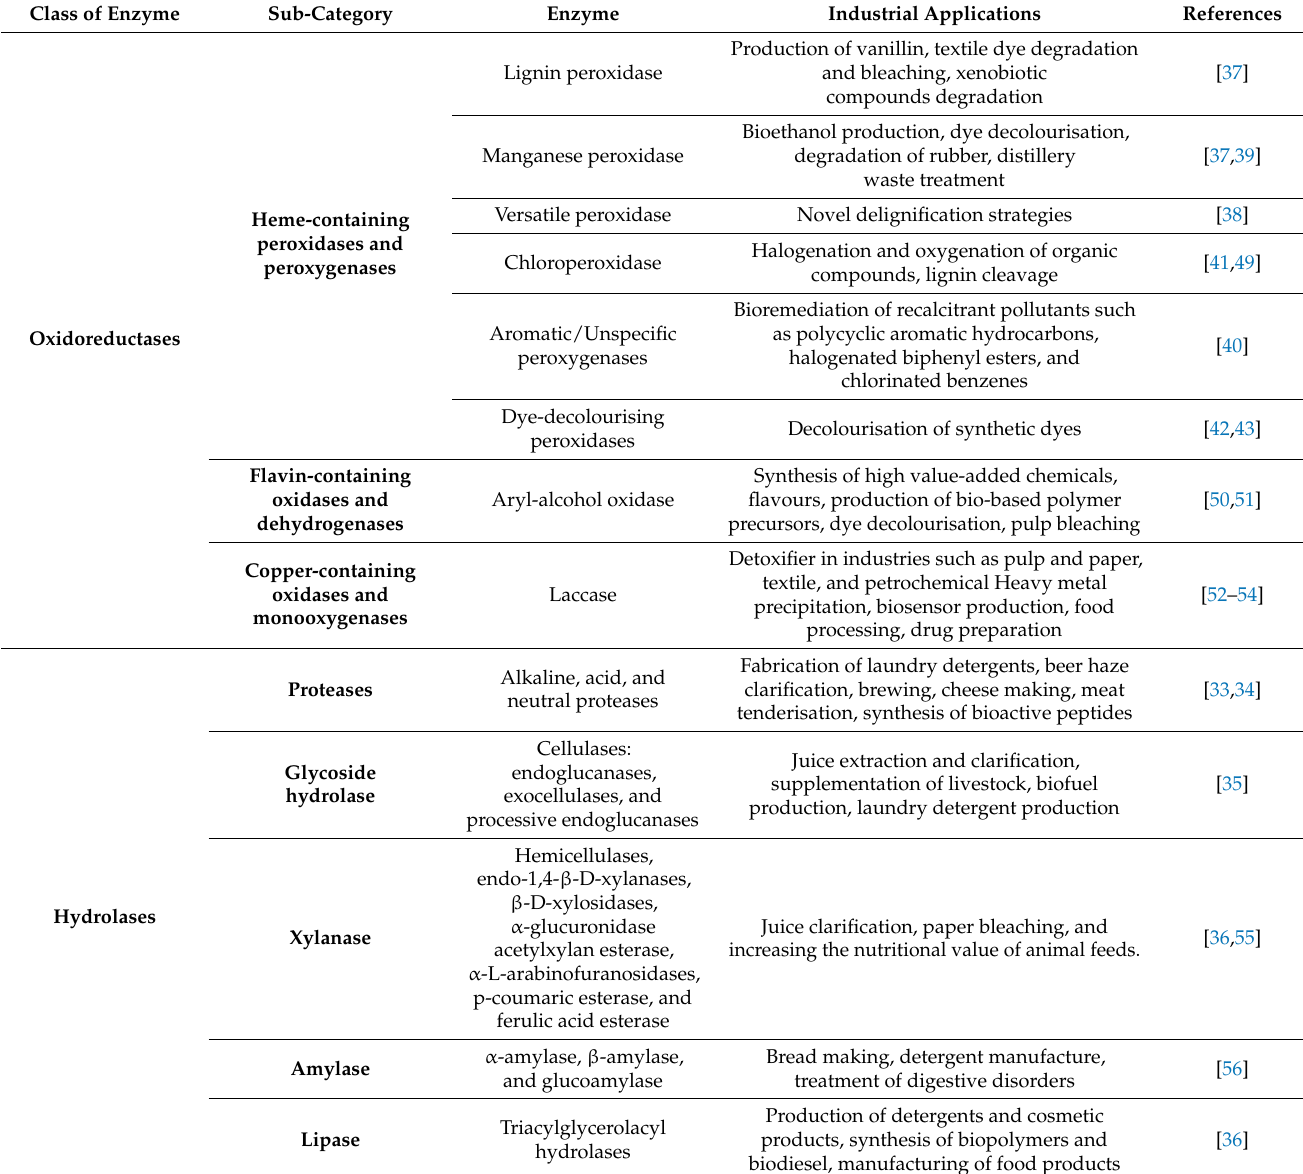
Table 1. Economically significant enzymes produced by basidiomycetes and